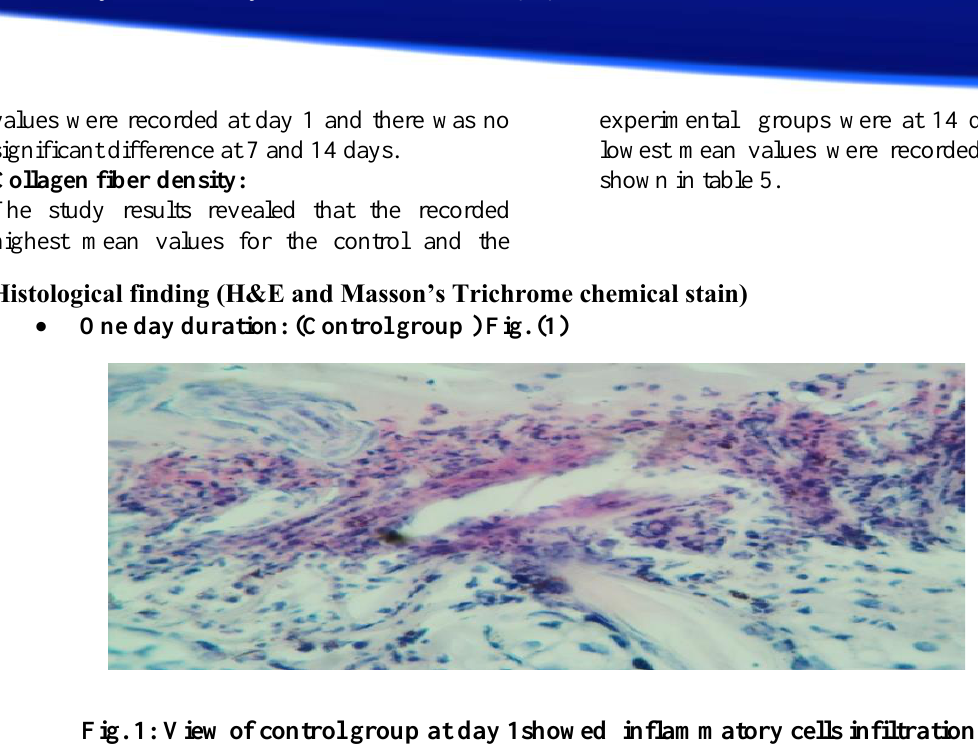
Fig. 1: View of control group at day 1showed inflammatory cells infiltration and scab,H&E,X40.